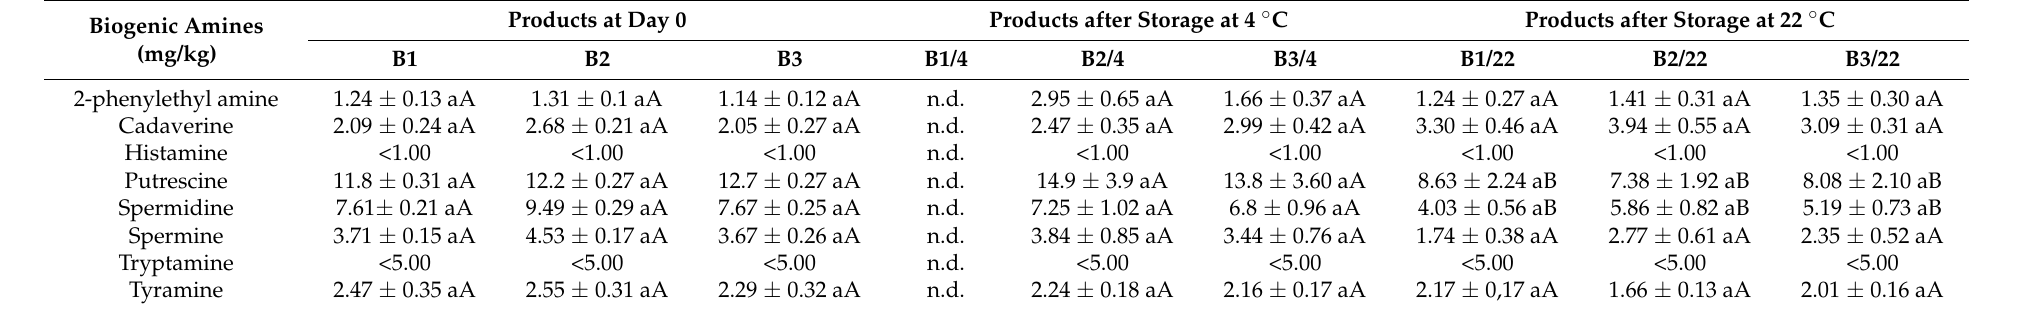
Table 4. Presence of selected biogenic amines in HPB bars immediately after production (time 0) and after 3 months of storage at 4 ◦ C and 22 ◦